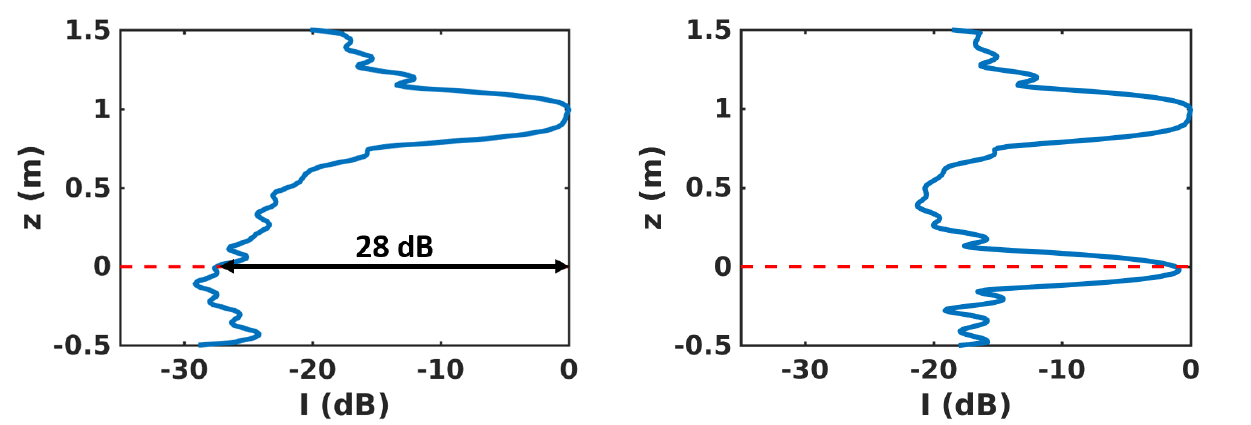
( c ) Volume only. Mean intensity profile. ( d ) Volume over ground. Mean intensity profile. Figure 12. Simulated intensity tomograms corresponding to the configuration of Figure 2 and Table 1, with x = 0 m.